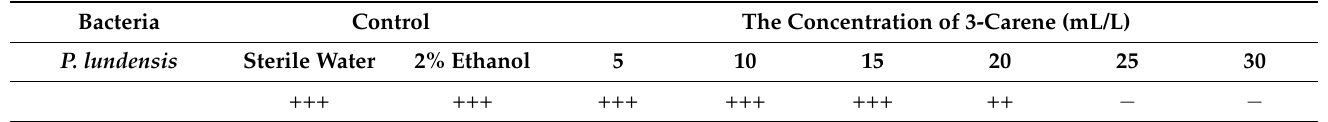
Table 1. Minimum inhibitory concentration (MIC) against Pseudomonas lundensis .